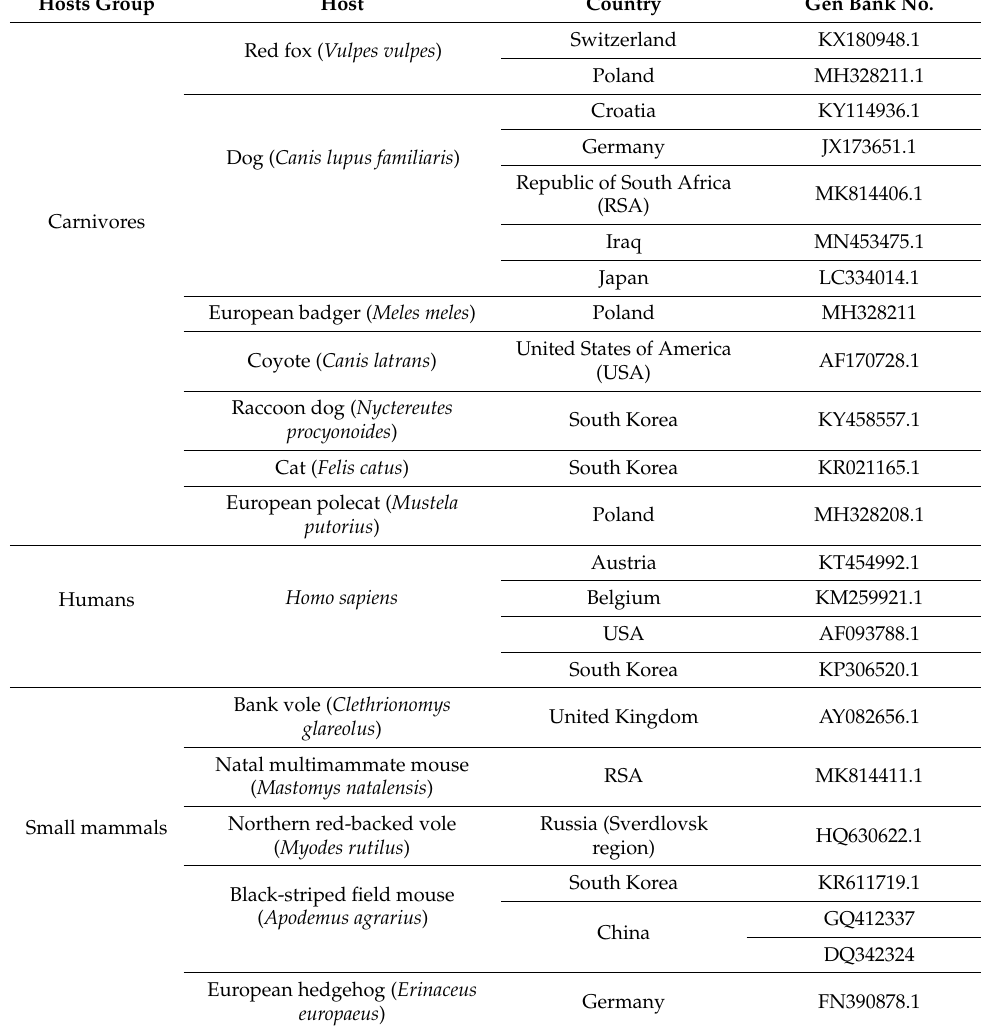
Table 1. Examples of Anaplasma phagocytophilum 16S rDNA sequences with 100% similarity to our 16S rDNA sequences, from the NCBI